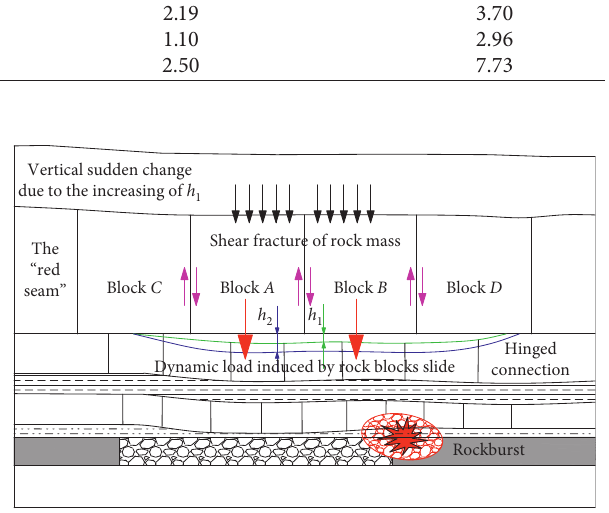
Figure 6: Schematic diagram of rockburst principle triggered by shear fracture of “red